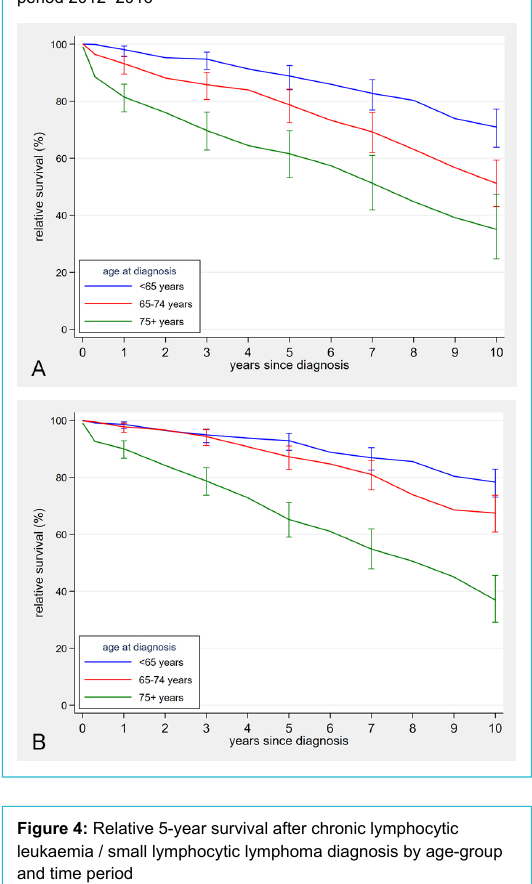
Figure 3: Age-specific relative survival curves of chronic lympho- cytic leukaemia / small lymphocytic lymphoma patients,